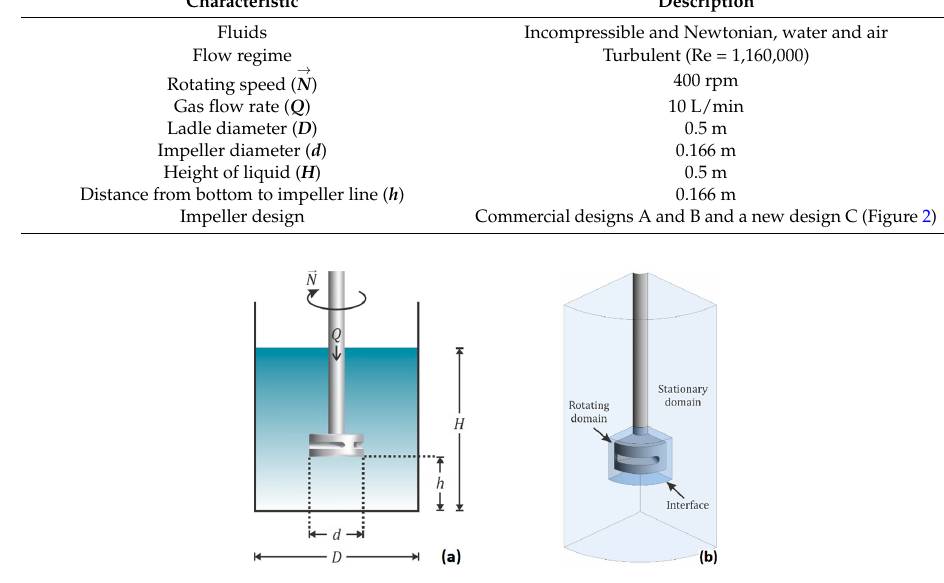
Figure 1. ( a ) Schematic representation of the batch degassing ladle, indicating the rotating speed, (cid:2170)(cid:4652)(cid:4652)(cid:1318) , and the gas flow rate, Q and the geometric features of the ladle; ( b ) Interphase between the rotating frame of reference and the fixed frame of reference showing the two regions of the ladle (the mobile frame of reference and the fixed frame of reference).